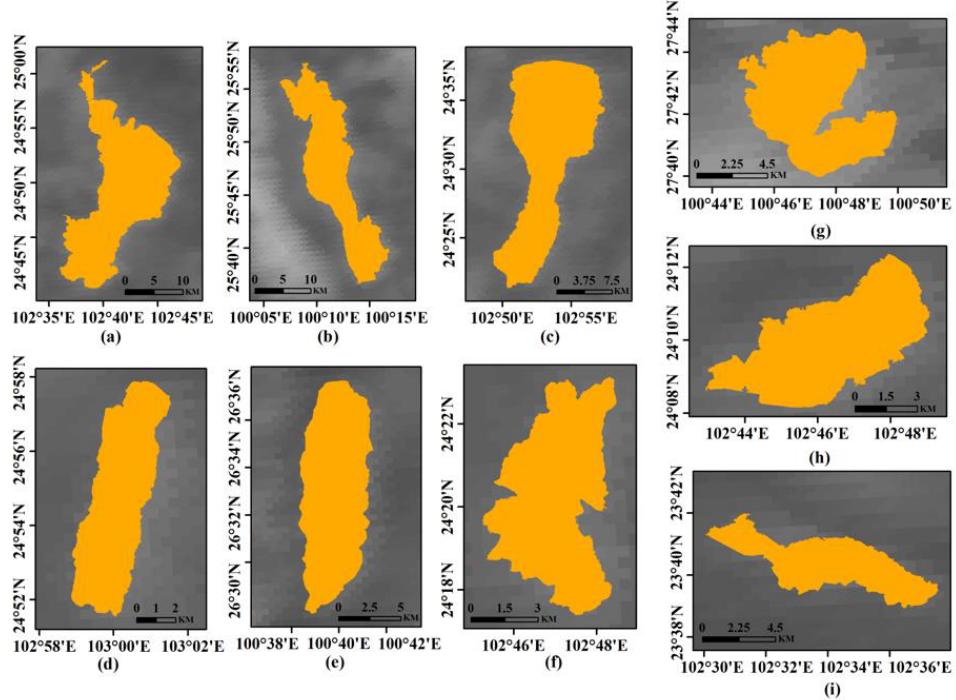
Figure 2. Nine plateau lake boundaries: ( a ) DCL, ( b ) ERL, ( c ) FXL, ( d ) YZL, ( e ) CHL, ( f ) XYL, ( g ) LGL, ( h ) QLL and ( i )